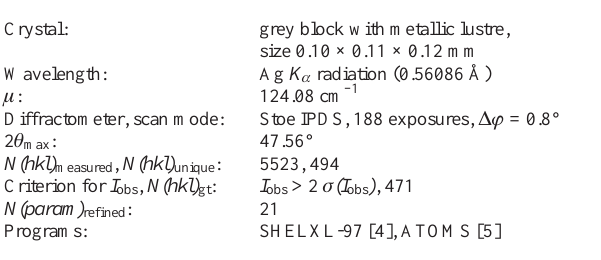
Table 1. Data collection and